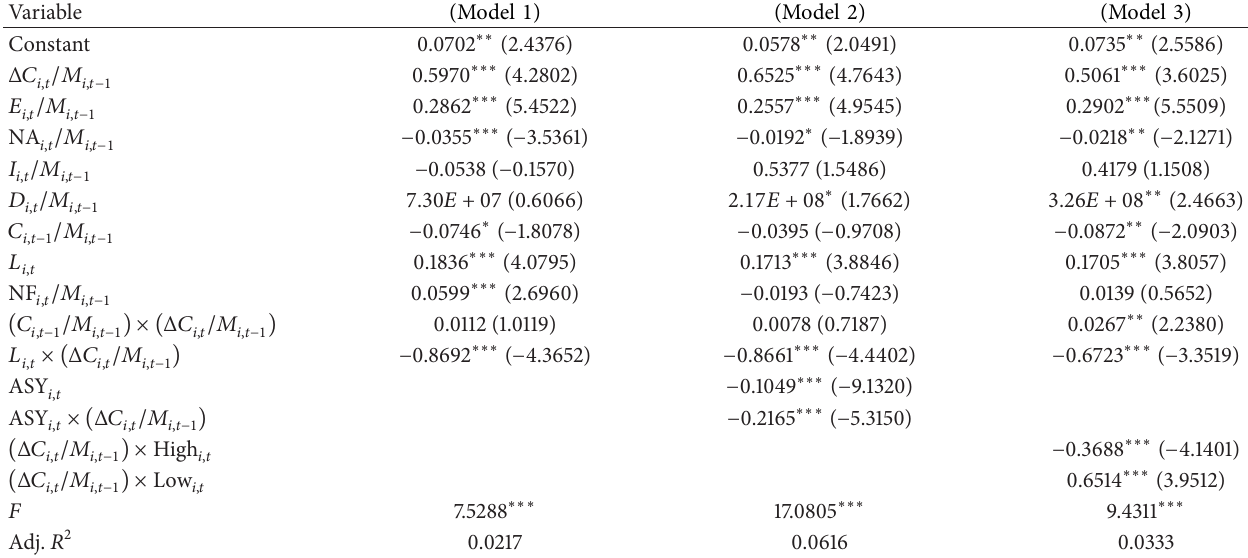
Table 6: Multiple regression